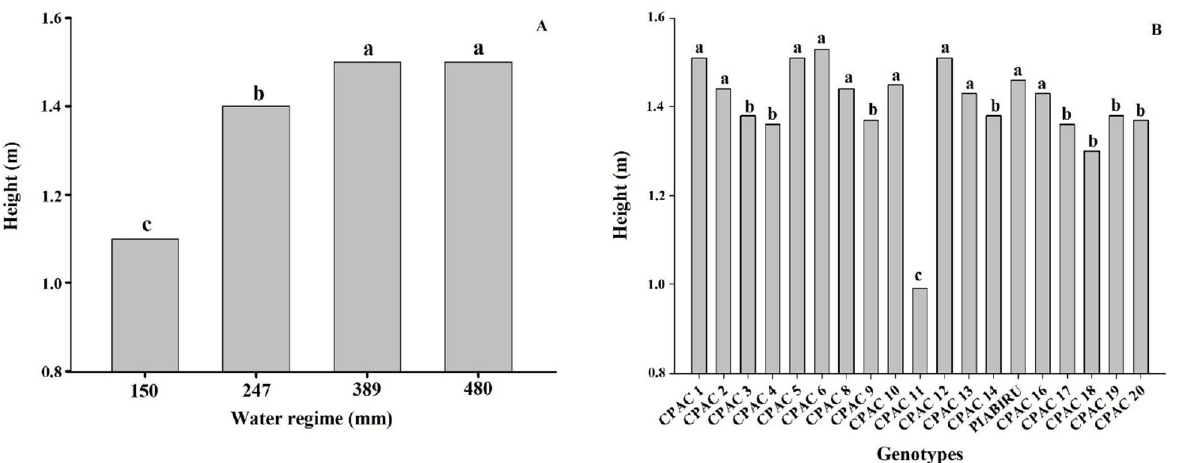
Figure 2. Height of different quinoa genotypes under 4 water regimes. ( A ) Effect of 4 water regimes in plant height in 20 quinoa genotypes. ( B ) Means followed by the same lowercase letter do not differ according to the Scott–Knott test at 5% probability.